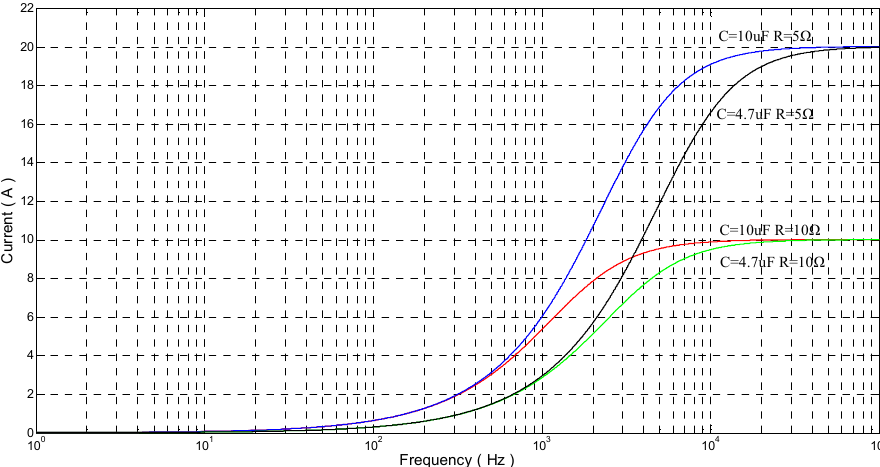
Figure 9. Frequency domain model of the circuit with piezoelectric stack actuators.